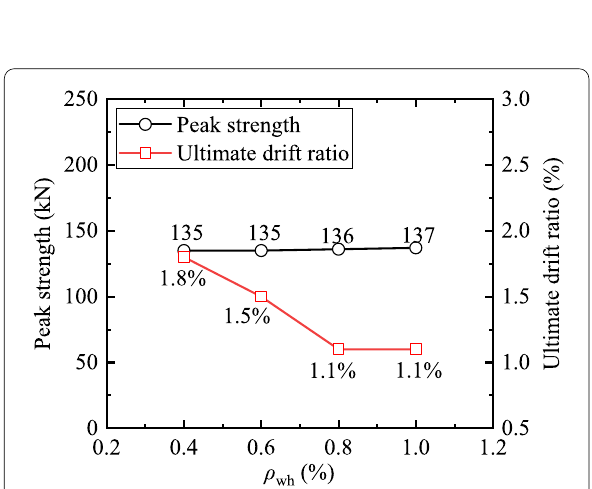
Fig. 18 Peak strength and ultimate drift ratio of specimens versus horizontally distributed reinforcement ratio.